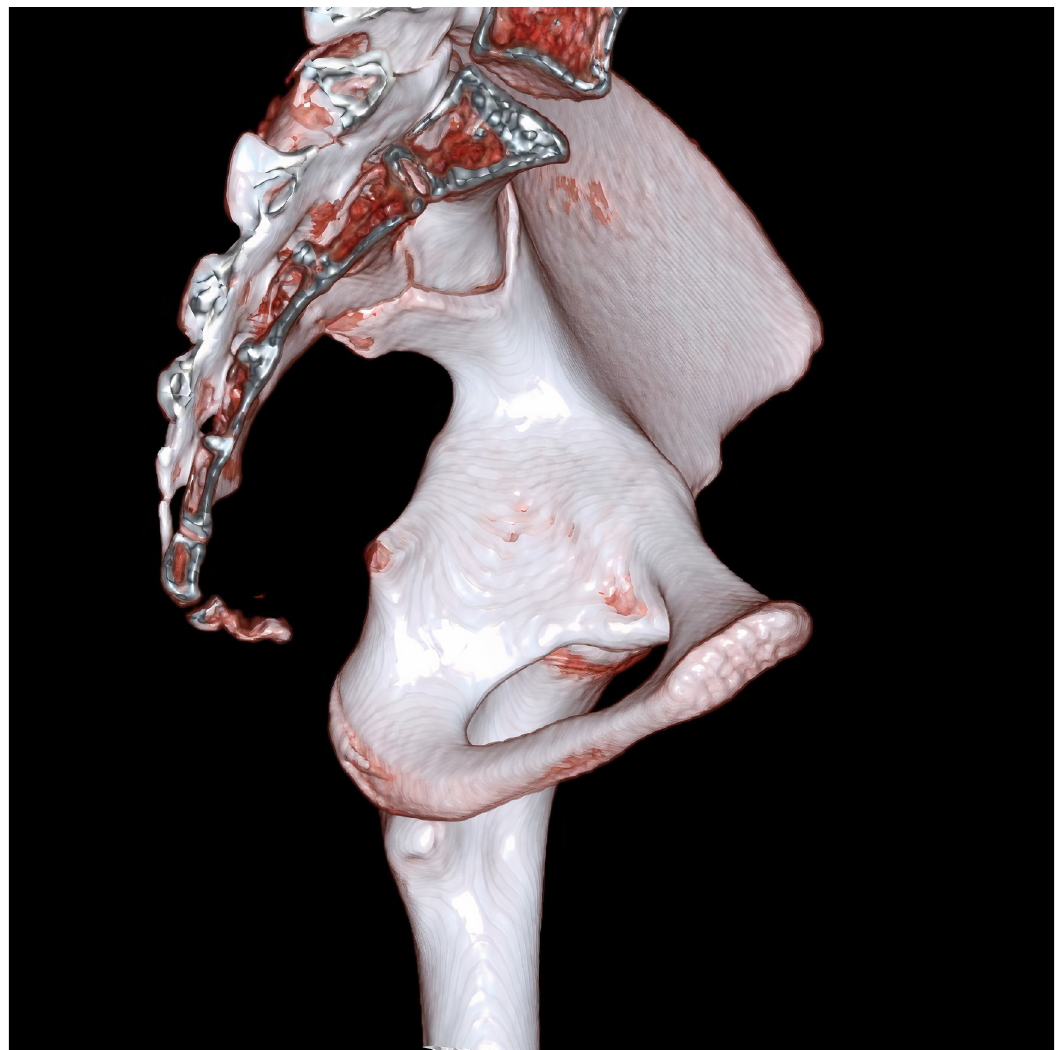
Fig 1. For a patient who is a 16-year-old girl, the virtual rendering technique (VRT) computed tomography image shows that all three synchondrosis regions are closed.